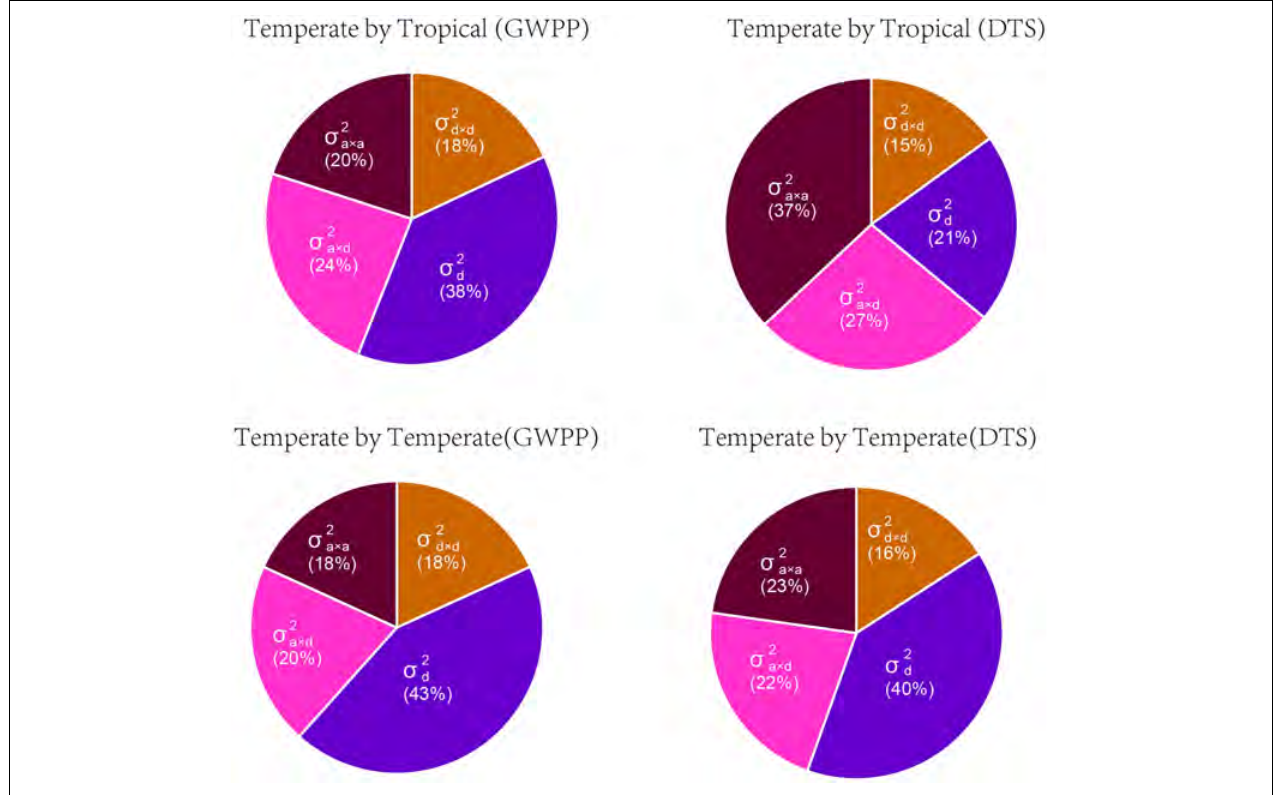
FIGURE 4 | The relative contributions of genetic variance components for mid-parent heterosis for grain yield per plant (GWPP) and days to silking (DTS). Variance components predicted by Bayesian generalized linear regression: σ 2 d , dominance variance; σ 2 d × d , dominance-by-dominance variance; σ 2 a × d , additive-by-dominance variance; and σ 2 a × a , additive-by-additive